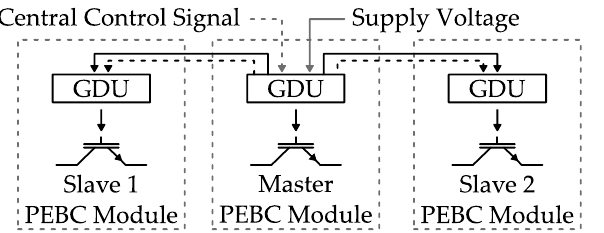
Figure 8. Photo of the demonstrator high-power test circuit with capacitor banks containing individual PEBC modules (left) and control inductance (right). The device under test ( DuT ) is placed in a spatially separate area for reasons of personnel and system safety.